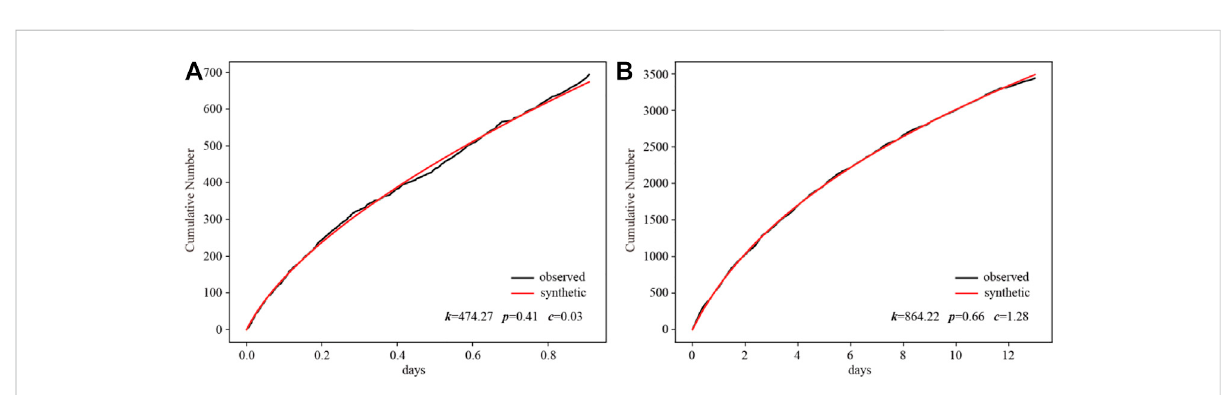
FIGURE 7 Fit of the modi fi ed Omori ’ s law to the earthquake sequence (A) before and (B) after the deployment of three portable